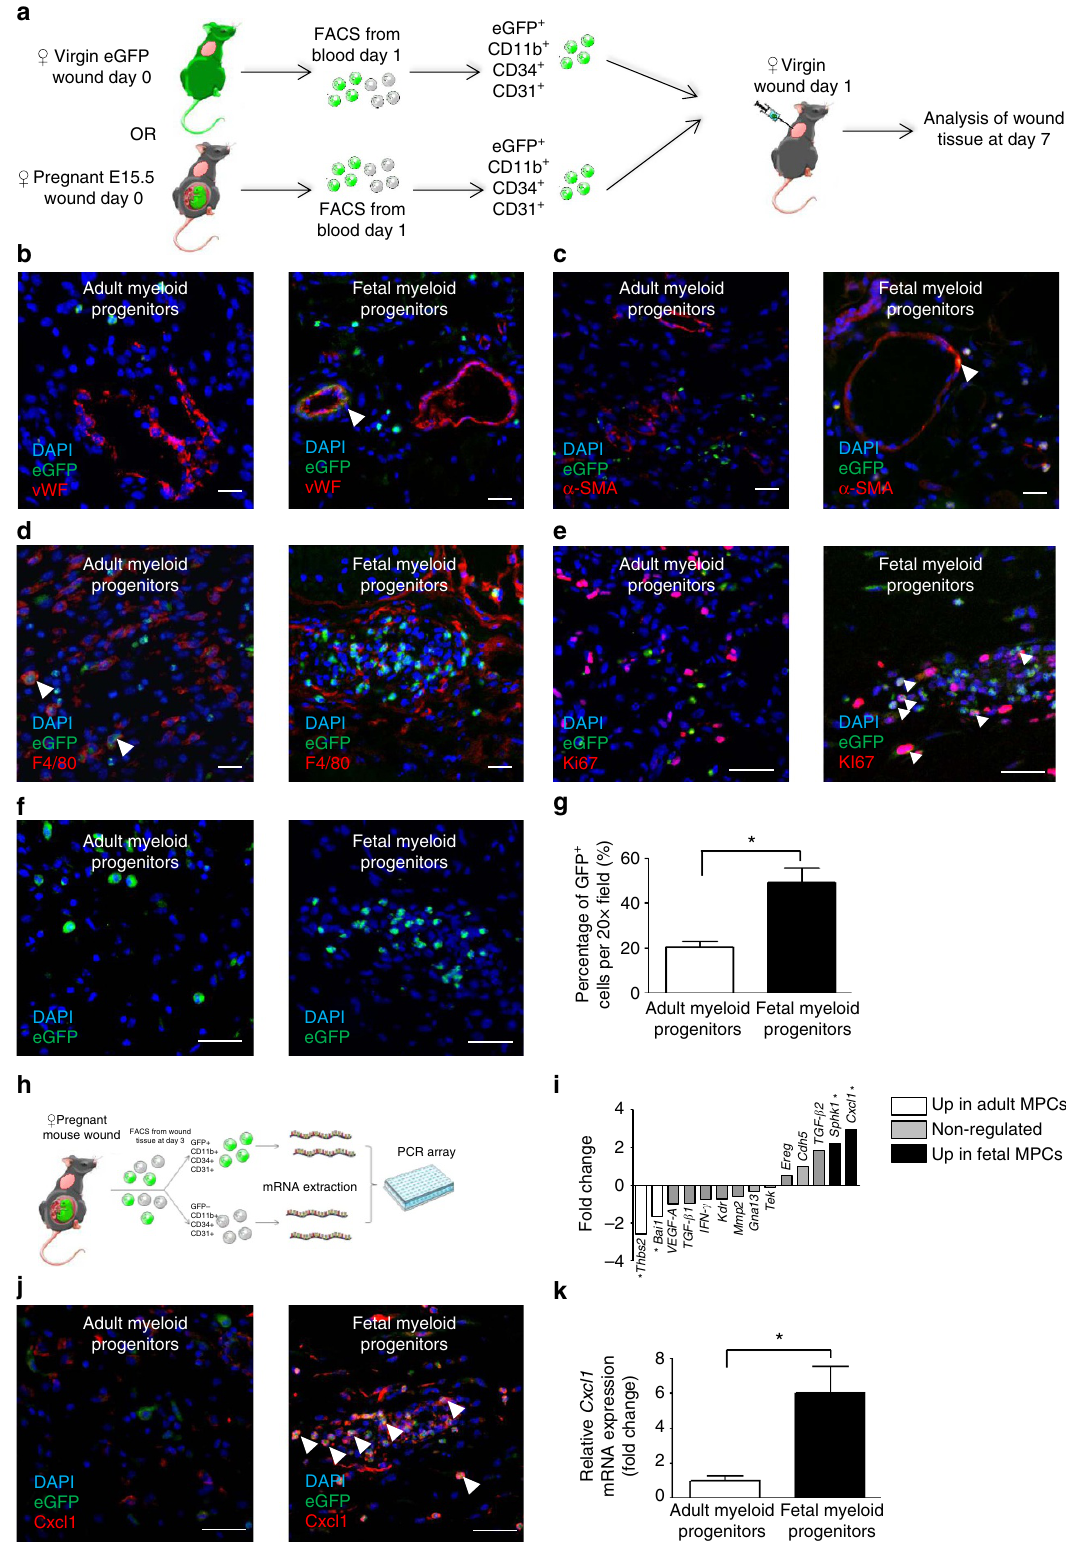
vessel (Fig. 5b and Supplementary Fig. 11). In addition, some eGFP þ fetal MPCs-derived cells expressed smooth muscle cell actin ( a -SMA) (Fig. 5c) but never macrophage markers (F4/80) (Fig. 5d). By contrast, following the injection of eGFP þ